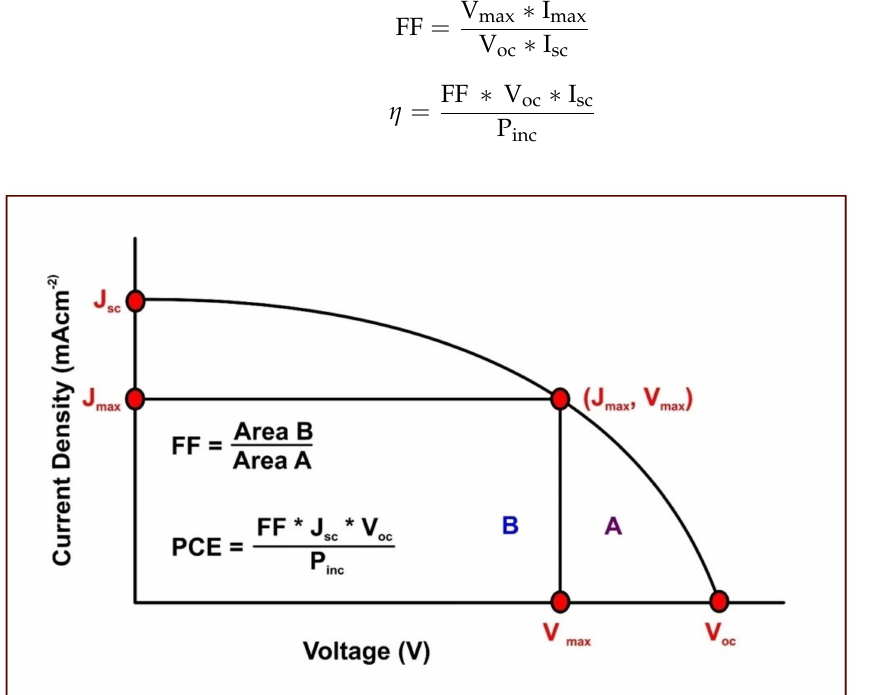
Figure 4. Current–voltage curve for evaluating DSSC performance using the cell parameters. Modi- fied after reference